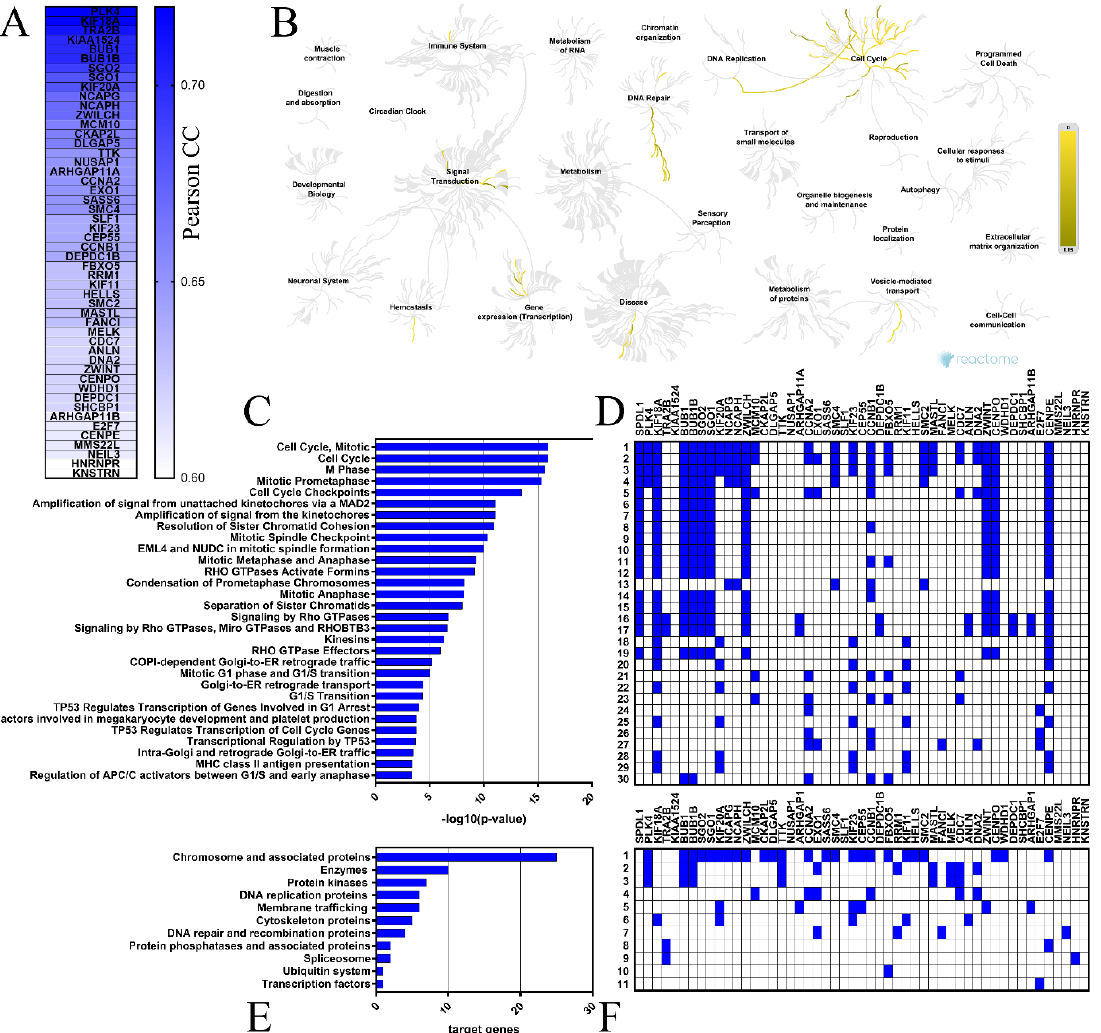
Figure 4. Functional enrichment analyses for the top 50 genes positively correlated with SPDL1 in CRC. ( A ) These genes are depicted with the corresponding Pearson correlation coefficient (Pearson CC) values. ( B ) The Reactome Pathway hi ‐ erarchy panel. ( C ) Bar chart of the top 30 Reactome pathways based on the enrichment scores [ ‐ log10 ( p ‐ value)]. ( D ) Heatmap of the top 30 Reactome pathways based on the target genes. ( E ) Bar chart for all terms in BRITE functional hi ‐ erarchies. The horizontal axis represents the number of genes enriched in KEGG Brite terms represented on the vertical axis. ( F ) Heatmap for all terms in BRITE functional hierarchies based on the target genes.